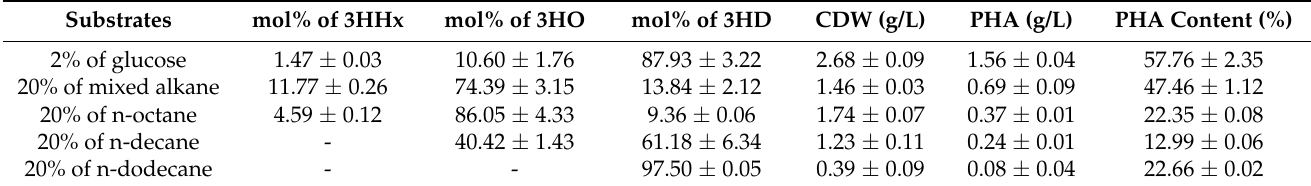
Table 1. Cell growth, PHA production, and monomer composition by P. resinovorans in various carbon sources.